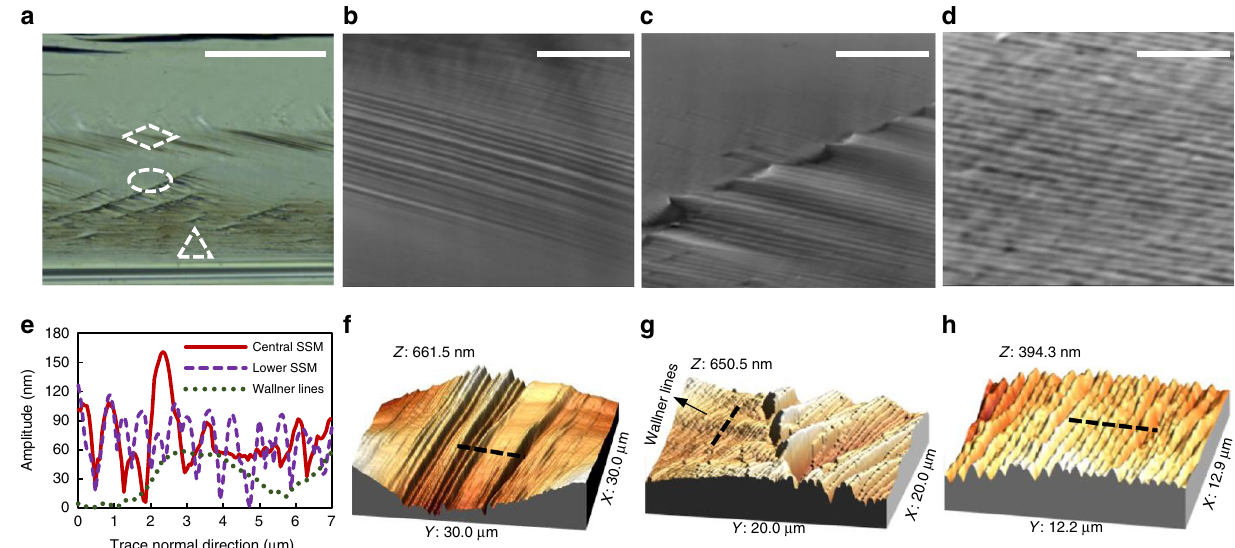
Fig. 5 Special surface marks on the (110) plane for a rapid propagation. a Digital image showing different marks at different loci. b – d Local details obtained by SEM which correspond to the framed regions in parallelogram, ellipse, and triangle, respectively. e Pro fi le (wavelength and amplitude) of the Wallner lines and the SSMs measured along the dashed lines presented in f – h . f – h Topographies of the SSM in the regions corresponding to b – d . Scale bars: a (100 μ m), b (10 μ m), c (10 μ m), and d (5 μ